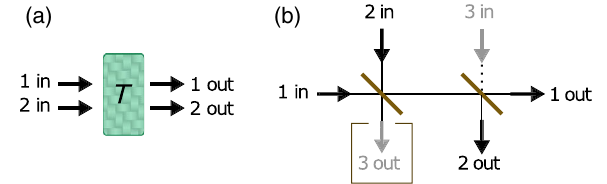
FIG. 4. Implementation of the lossy beam splitter with apparent nonlinear loss. (a) One approach would be to implement the transformation directly by a single device. The special trans- formation coefficients may be achieved with a novel material, e.g., a metamaterial. (b) The decomposition reveals a much simpler implementation consisting of two 50 ∶ 50 beam splitters (along with single-mode phase shifts omitted from the diagram) and elucidates the simple role quantum interference plays with respect to the “ nonlinear loss."